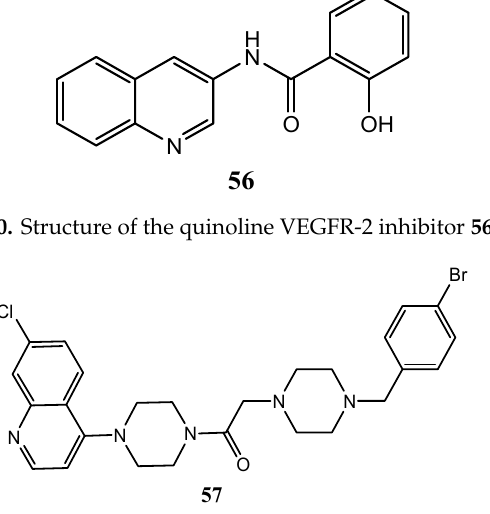
Figure 31. Structure of compound 57 , a 7-Chloro-4-(piperazin-1-yl)quinoline derivative with VEGFR-2 inhibition activity [134].